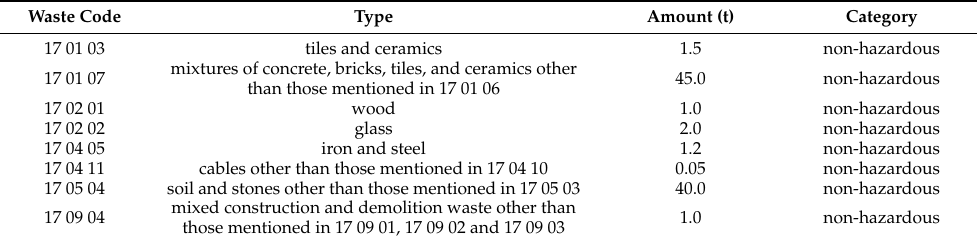
Table 6. Estimated amount of construction and demolition waste according to project